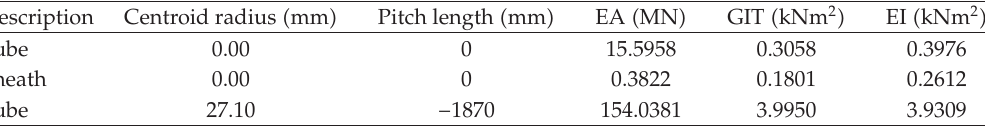
Table 11: Umbilical 8 parameters.